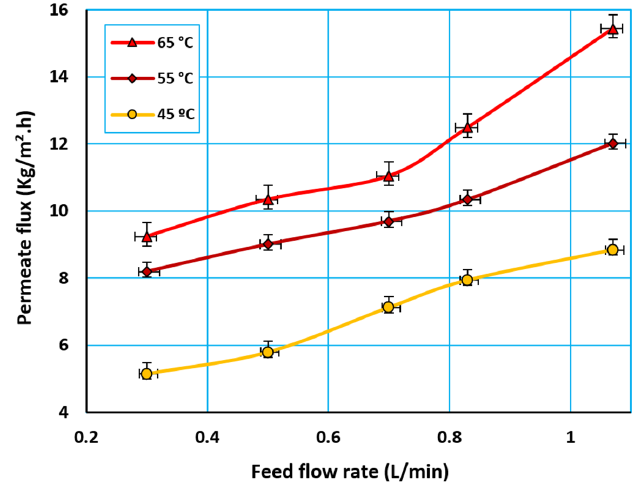
Figure 8. E ff ect of the feed flow rate on the permeate flux at di ff erent feed temperatures and a feed concentration of 35 g / L